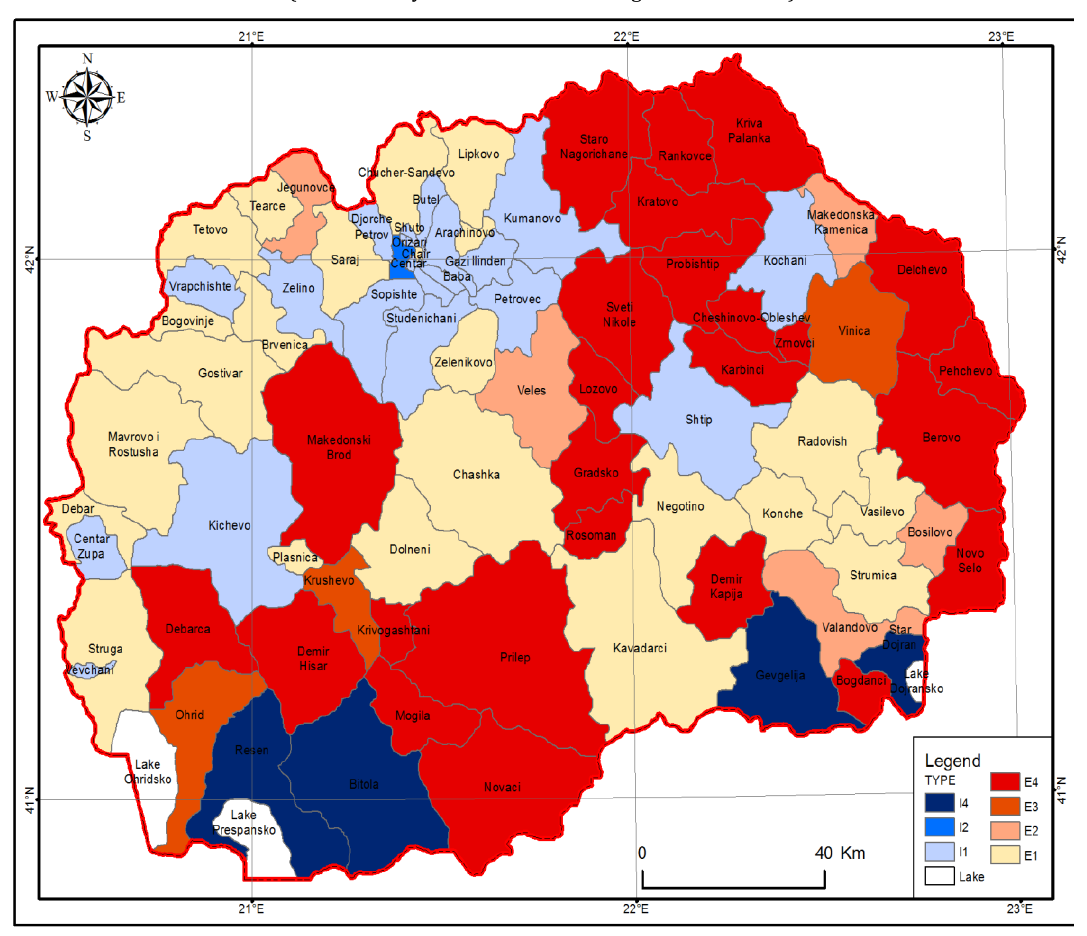
Fig. 4. Migration types, by municipalities in the period 2002-2013 (calculated by the authors, according to SSORM, map author,